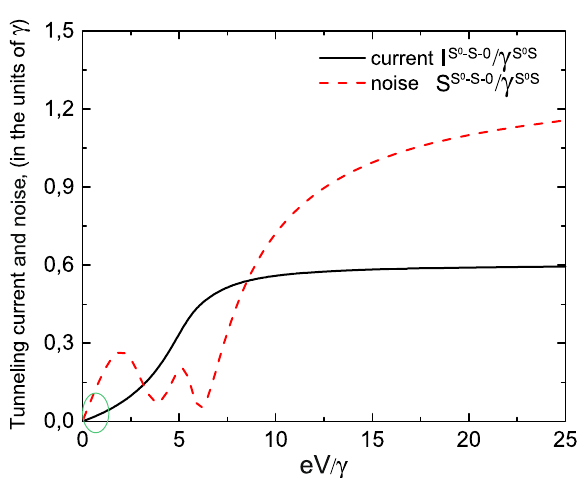
0 channel—red dashed curve. S − −